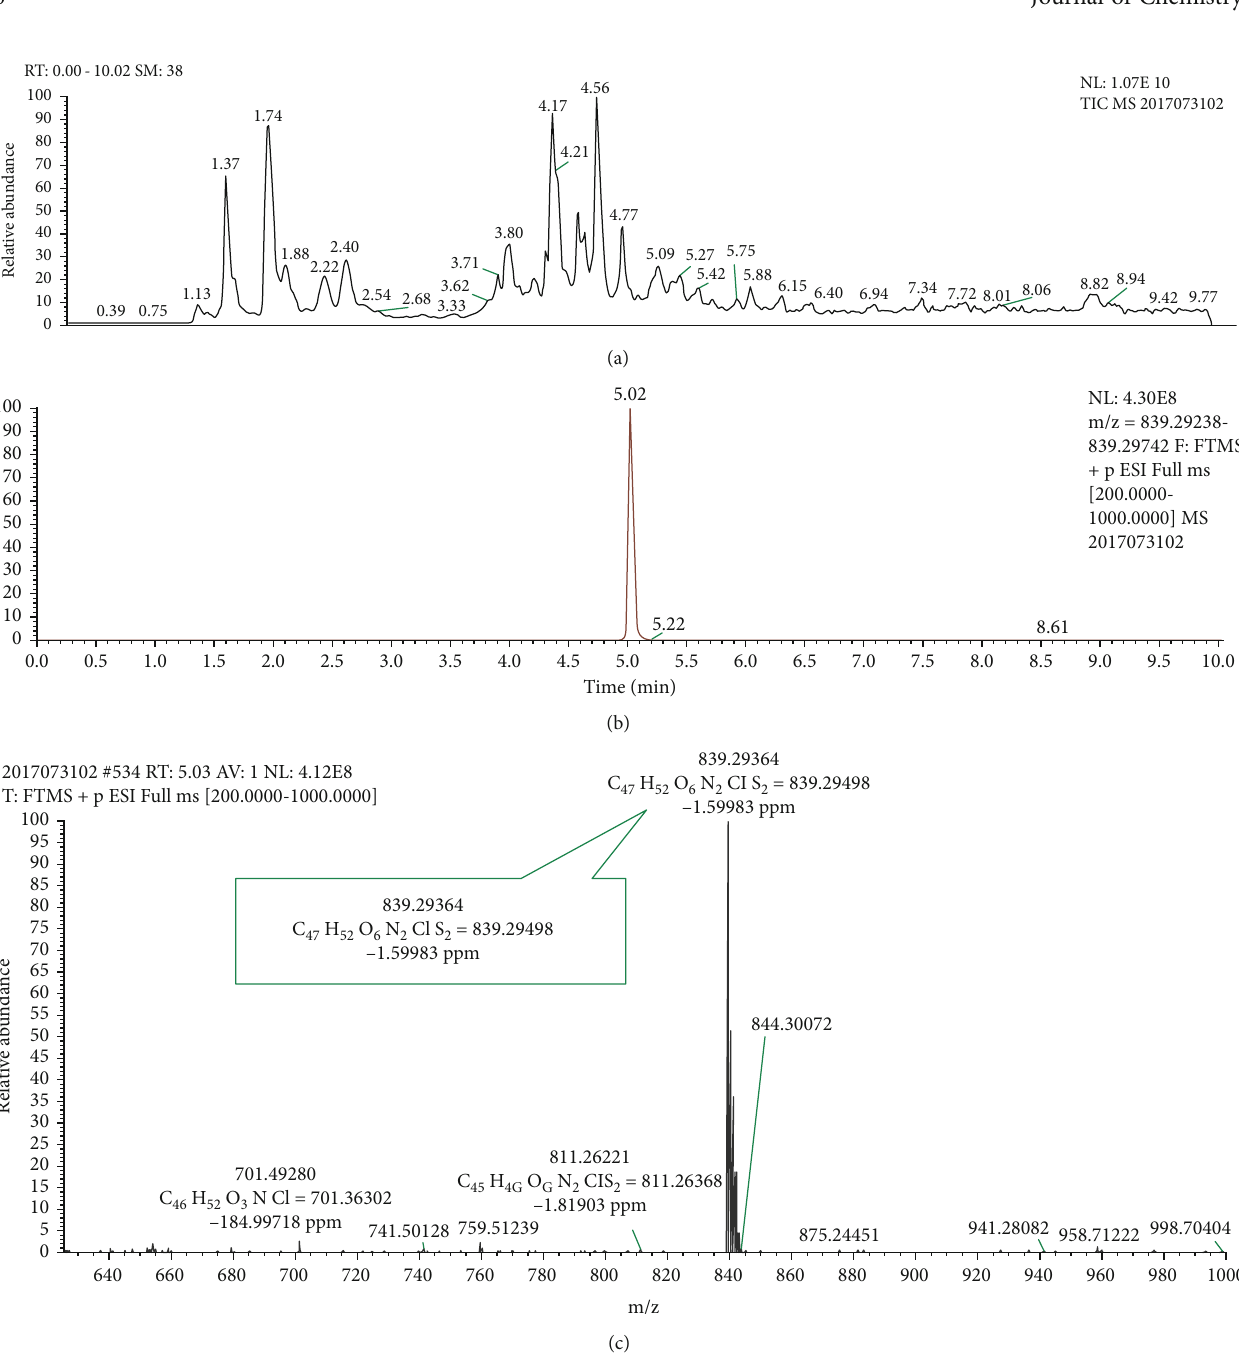
Figure 6: High-resolution mass spectrum of vanisulfane after the fl uorescent label ((a) total ion chromatogram TIC; (b) mass range graph; (c) mass range